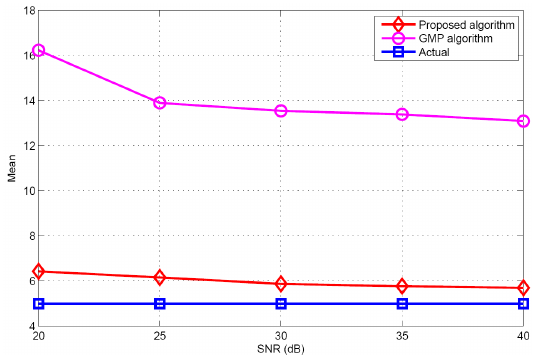
Figure 10. The mean of the estimated population versus SNR.